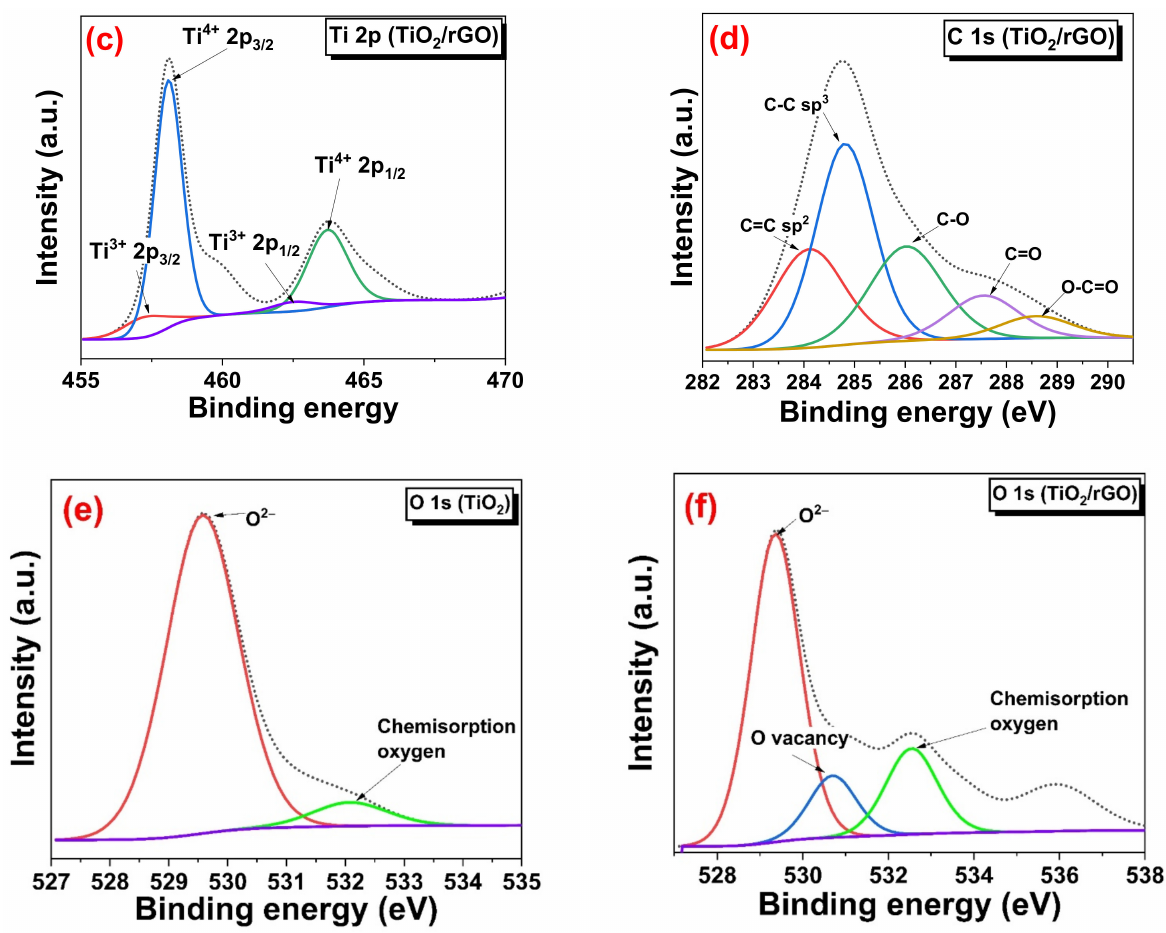
Figure 10. ( a ) XPS survey scan spectra, ( b ) narrow scan Ti 2p of TiO 2 , ( c ) narrow scan Ti 2p of TiO 2 /rGO, ( d ) narrow scan C 1s of TiO 2 /rGO, ( e ) narrow scan O 1s of TiO 2 , and ( f ) narrow scan O 1s of TiO 2 /rGO.